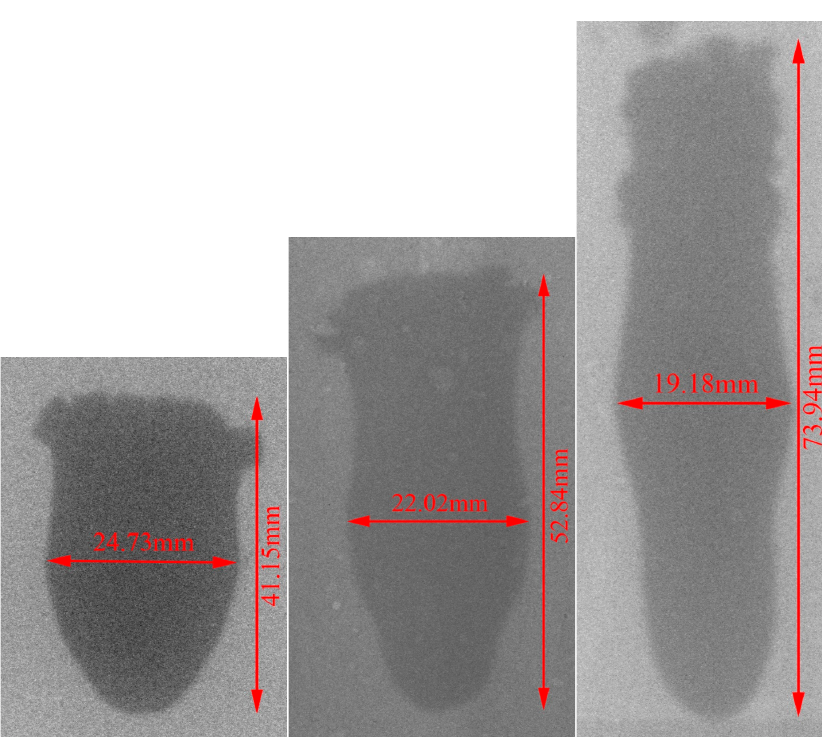
Figure 2. Radiograph of three EFPs with different L / D .